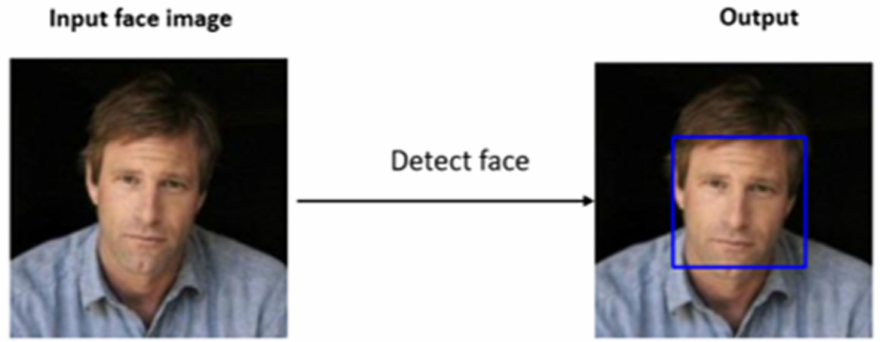
Figure 5. Face detection